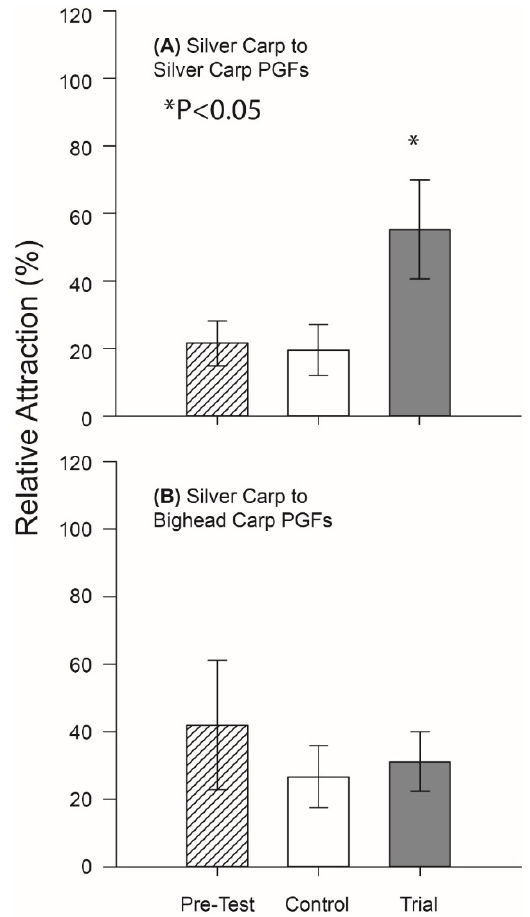
Figure 4. Distribution of masculinized Silver Carp in the rectangular test tank during tests of the PGFs found in PGF 2α -implanted carp odors. Mean percent time (±standard error) on the side to which the test odor was added is shown. Each experiment had three 10-min test periods during which time no stimulus was added (striped bar), following one in which well water control was added (open bar), followed by one in which a test stimulus was added (solid bar). Two test stimuli were tested as follows: ( A ) the PGFs mixture profile found in PGF 2α -implanted Silver Carp holding water, and ( B ) the PGFs mixture profile found in PGF 2α -implanted Bighead Carp holding water. n = 7 for each test. * p < 0.05 by 1-tailed paired t -test.